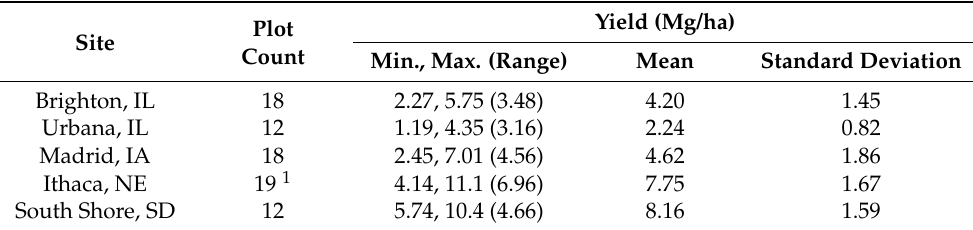
Table 2. Summary of perennial grass yield data available for model development.